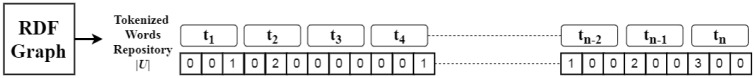
Traditional feature representation model.